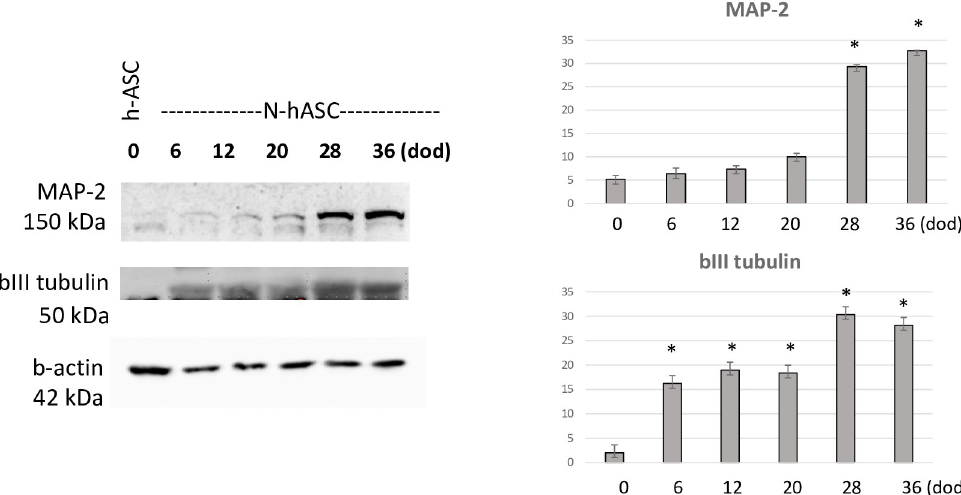
Fig 4. Representative blots and quantification of neuronal markers. Left panels, representative blots of MAP-2 and bIII tubulin neuronal marker protein expression in hASCs and NhASCs upon neuronal induction with neurobasal differentiation media over time, from 0 to 36 days of differentiation. From top to bottom, blots show signals of specific bands for neuronal MAP-2 and bIII tubulin and housekeeping b-actin (indicating similar protein loading in all samples). Right panels, densitometric quantification of MAP-2 neuronal marker protein expression upon neuronal induction (p < 0.05 in undifferentiated hASCs at 0 days vs. 28 and 36 days of differentiation); and quantification of bIII tubulin neuronal marker protein expression upon neuronal induction (p < 0.05 in hASCs at 0 days vs. 6, 28 and 36 days of development). AU, arbitrary units; Dod, day of differentiation; hASCs, human adipose stem cells; NhASCs, neuronal transdifferentiated human adipose stem